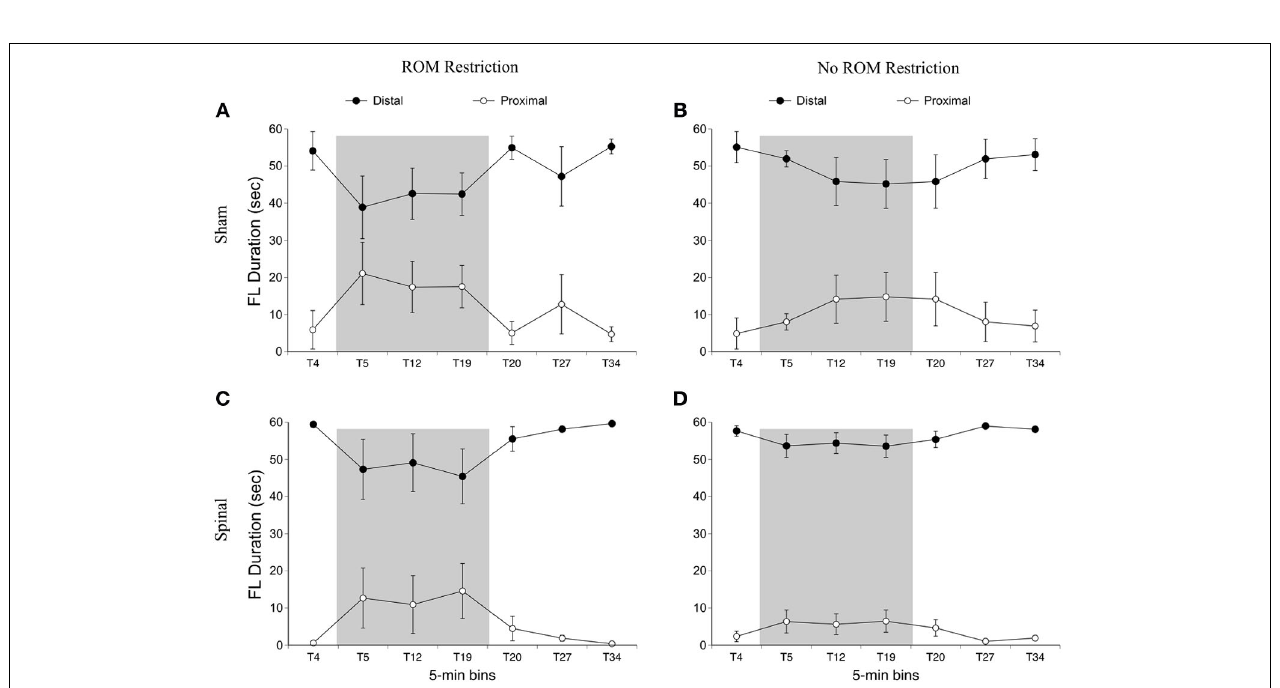
FIGURE 5 | Dorsal-ventral forelimb trajectories for sham and spinal P10 rats by ROM restriction condition. Graphs show duration of time spent in distalandproximaltrajectoryareasfor1-minsectionsduringbaseline,theROM restriction period, and the post-ROM restriction period for (A) sham subjects